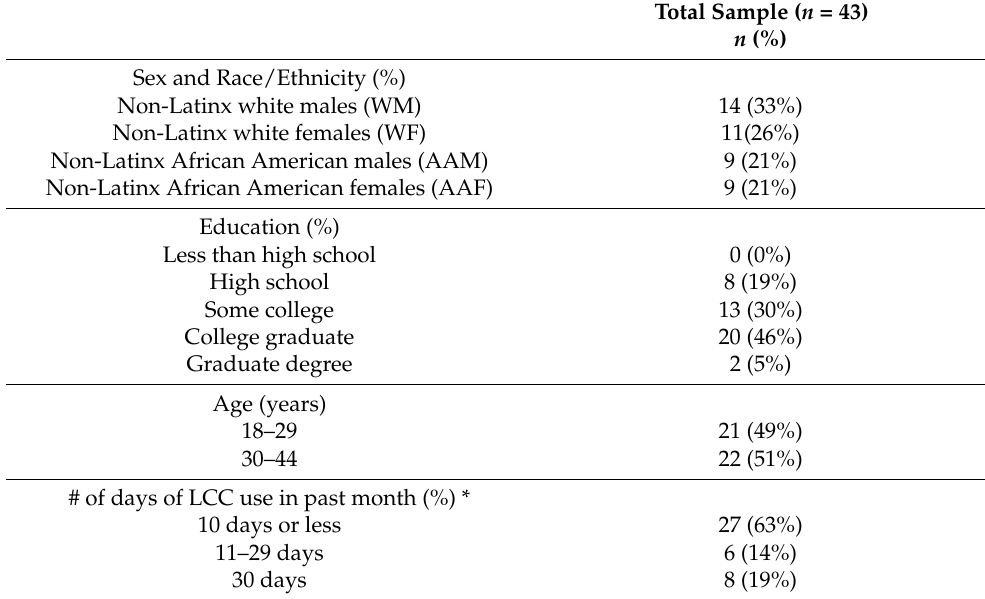
Table 1. Participant